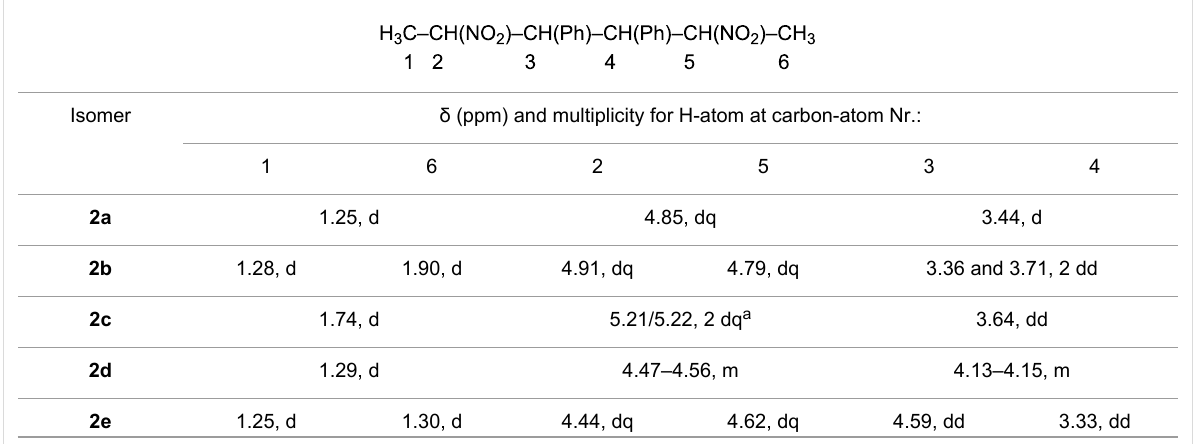
Isomer δ (ppm) and multiplicity for H-atom at carbon-atom